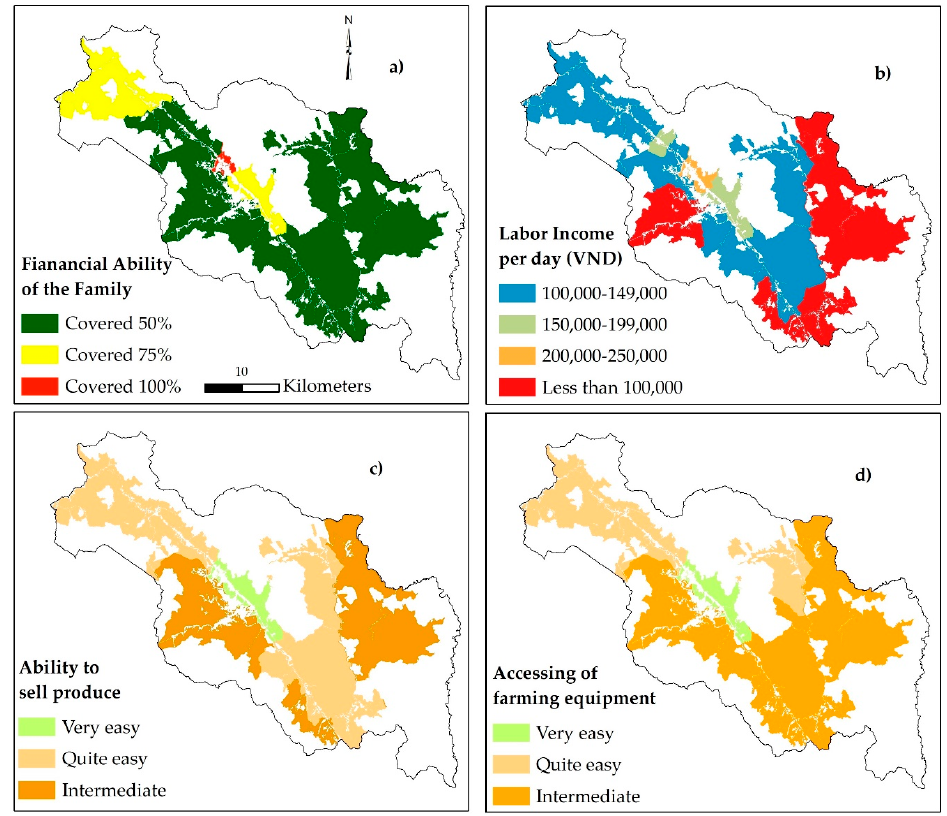
Figure 5. Geographic distribution of economic criteria in A Luoi district: ( a ) financial ability of the family; ( b ) labor income per day; ( c ) ability to sell produce; and, ( d ) accessibility of